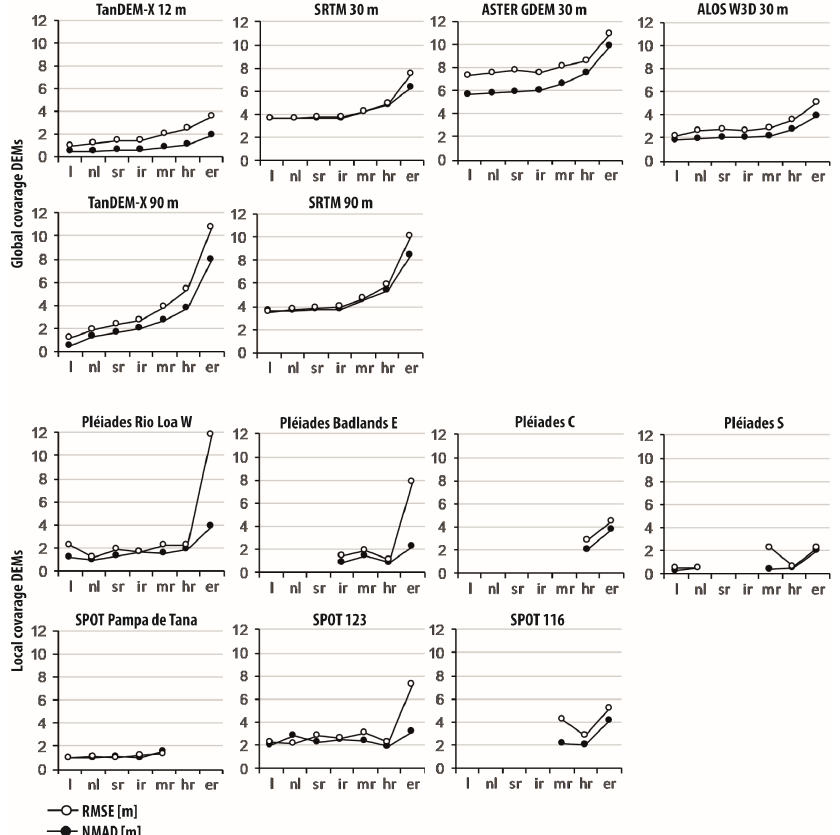
Figure 6. Calculated root mean squared error (RMSE) of elevation differences according to the classified terrain ruggedness index from level to extremely rugged. Categorization of classes was conducted after Riley et al. (1999). Classes are level (l), nearly level (nl), slightly rugged (sr), intermediate rugged (ir), moderately rugged (mr), highly rugged (hr), extremely rugged (er).